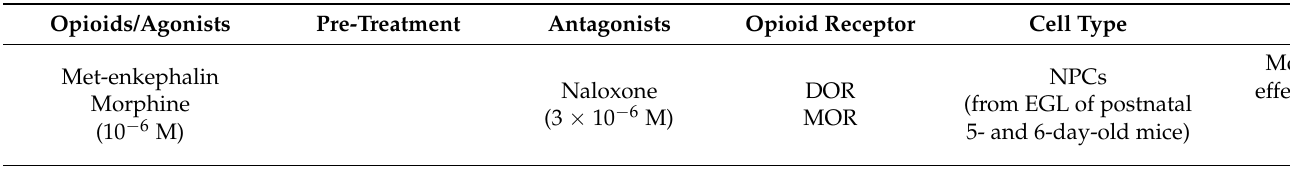
Table 1. Effects of endogenous opioids on stem cell proliferation and stress